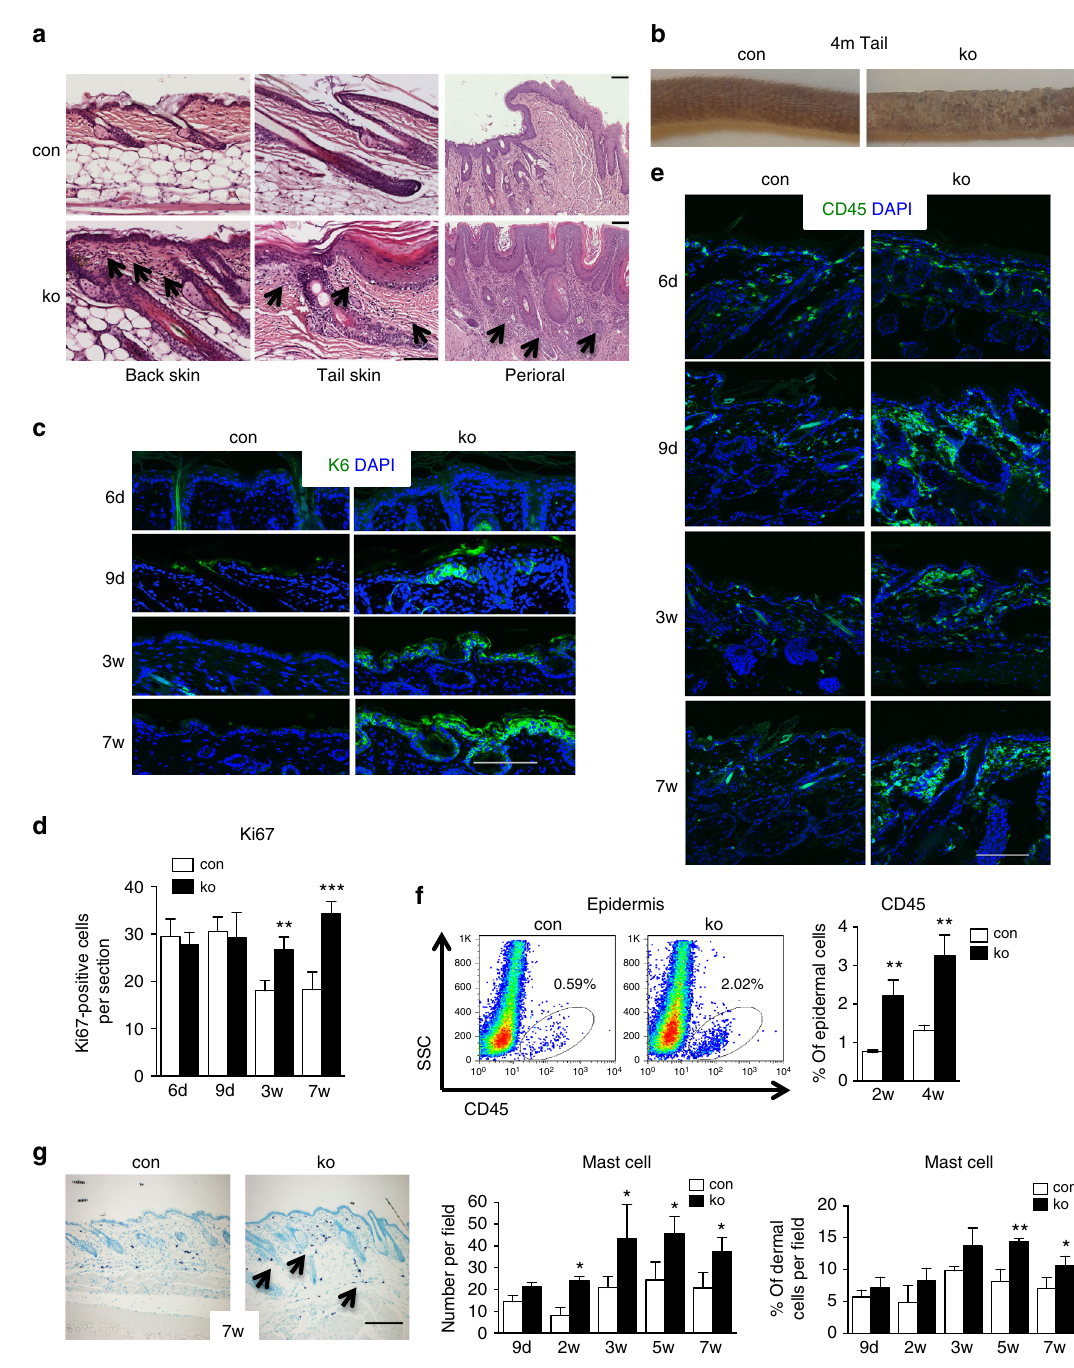
Fig. 1 Chronic skin in fl ammation in mice with a keratinocyte-restricted deletion of N-WASP . a H&E-stained back, tail, and perioral skin sections of 7-week- old mice ( n : 6/6). Arrows indicate increased dermal cellularity. b Representative image of tails of 4-month (4m)-old control and ko mice. c K6 immuno fl uorescence of back skin section of at indicated ages ( n : 4/4, mean ± SD, two-tailed unpaired t -test). d Quanti fi cation of Ki67 + cells in back skin epidermis sections ( n : 4/4, mean ± SD, two-tailed unpaired t -test). e CD45 immuno fl uorescence of back skin at the indicated ages ( n : 4/4). f FACS for CD45 + cells in back skin epidermis and quanti fi cation ( n : 3/3, mean ± SD, two-tailed unpaired t -test). g Representative toluidine blue staining for mast cells and quanti fi cation of mast cell in fi ltration in numbers per fi eld and ratio of dermal cells per fi eld ( n : 3/3, two-tailed unpaired t -test). Arrows indicate mast cells. Scale bars ( a , c , e , g ): 100 µ m (* p ≤ 0.05; ** p ≤ 0.01; *** p ≤